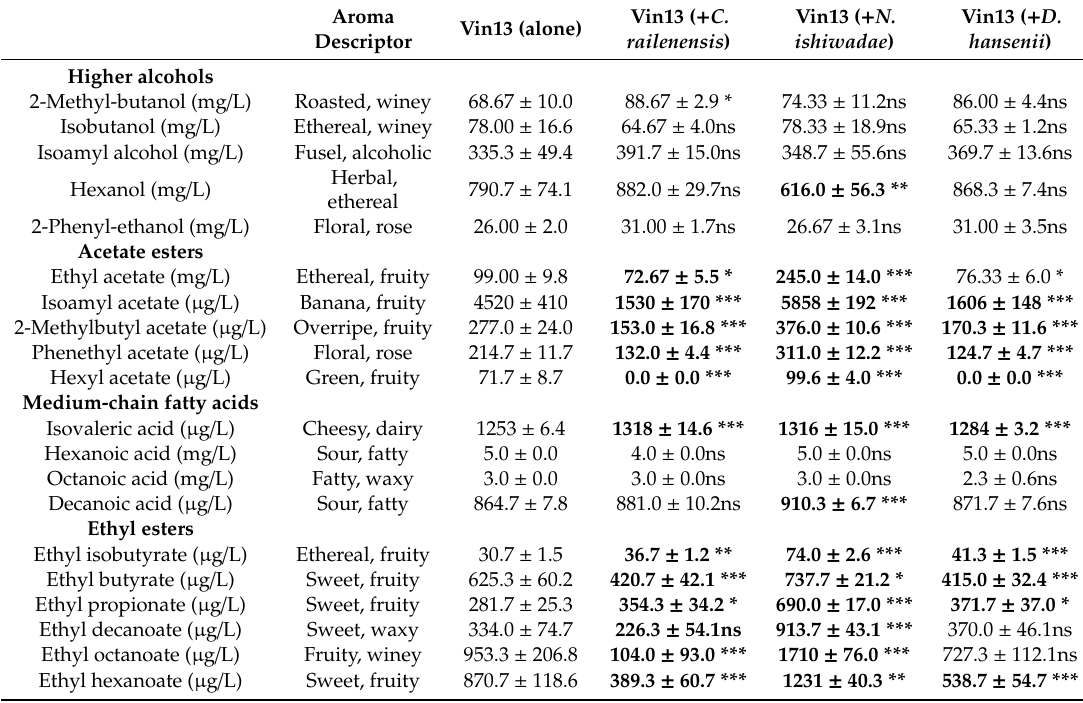
Table 3. Terpene and norisoprenoid composition of the Muscaris wines derived from the mixed-culture fermentations as determined with